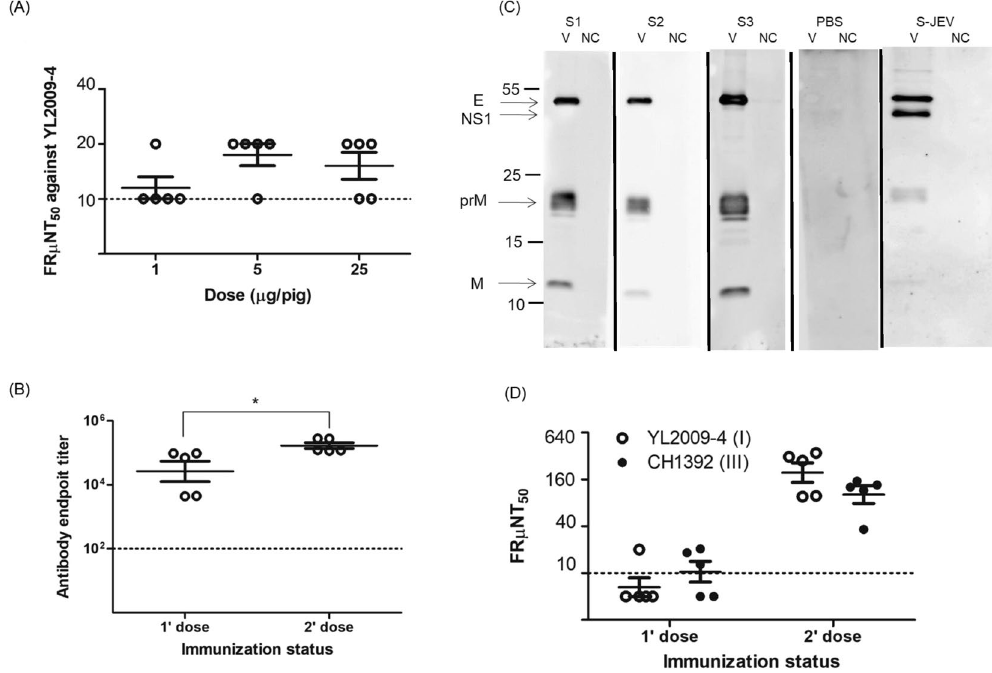
Figure 3. Immunogenicity of GI JEV VLPs in SPF swine. ( A ) Second-generation SPF swine (5 pigs each group) were inoculated with 1, 5, or 25 μ g GI VLPs with ISA201-adjuvant, and neutralizing antibodies in the serum specimens were determined by FR μ NT 50 . ( B ) SPF pigs (5 pigs each group) were immunized with 1 or 2 doses of 5 μ g GI VLP, and the antibody response was detected by swine Ag-ELISA. ( C ) The reactivity of antibodies against GI YL2009-4 virus proteins (V) and the cellular supernatant (NC) among 2-dose PBS- or GI VLP- immunized SPF swine (S1 to S3) was analyzed by western blot assay. The serum plasma collected from naturally infected swine (S-JEV) was a positive control. Full-length Western blots are presented in Supplementary Fig. S7. ( D ) SPF swine (5 pigs each group) were immunized with 1 or 2 doses of 5 μ g GI VLPs, and the heterologous neutralizing activity against GI and GIII viruses was determined by FR μ NT 50 . Data are mean ± SD and were compared by Student t test. * P <